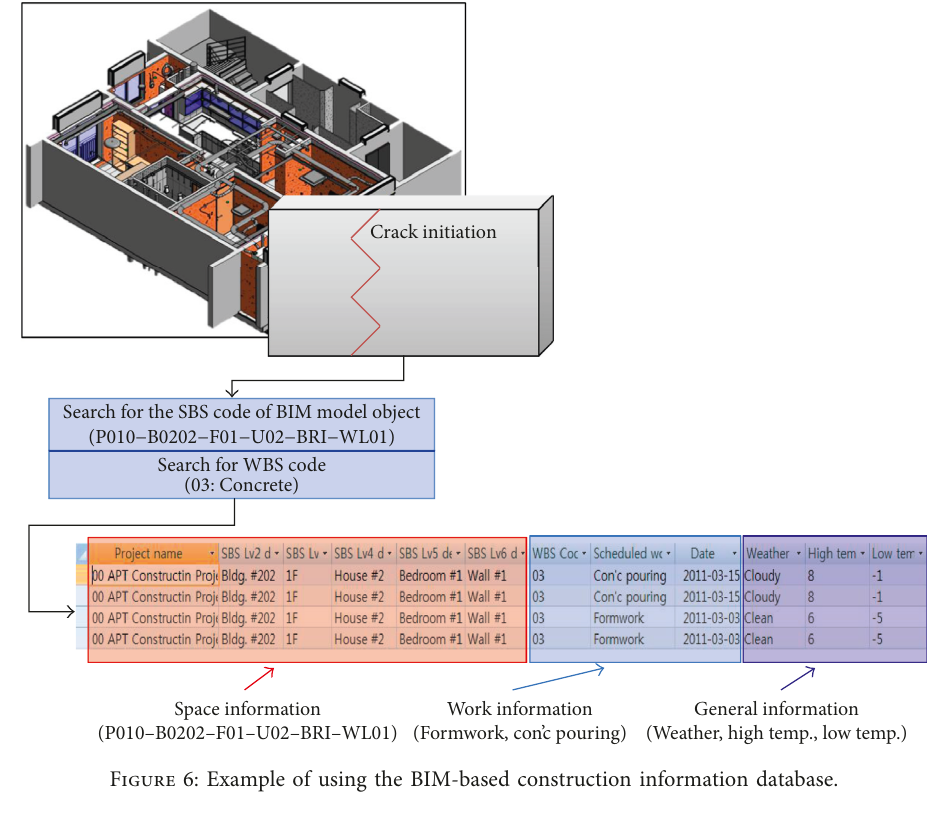
Figure 6: Example of using the BIM-based construction information